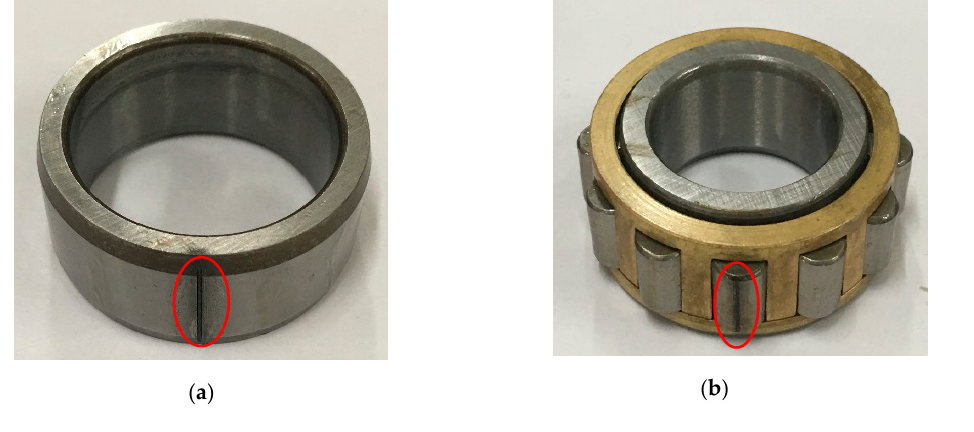
Figure 8. ( a ) Inner-race fault ( b ) rolling-element fault. Table 1. Fault characteristic